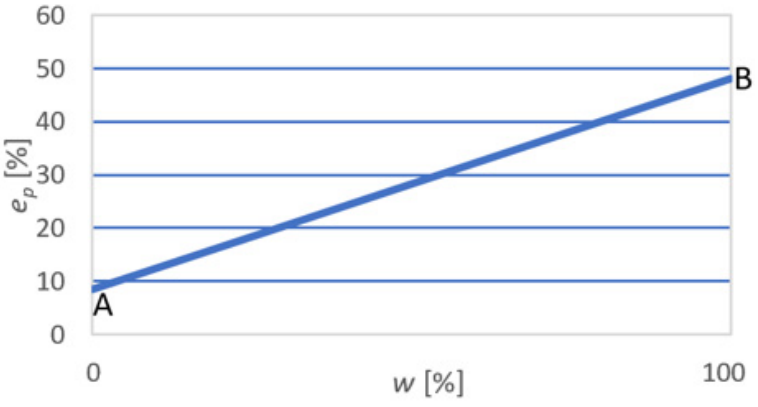
Figure 5. Energy performance of the bucket conveyor [22]. where: e p —percentage energy consump- tion; w —percentage load on the conveyor; A—energy consumption during no-load operation; and B—energy consumption when operating at full load.